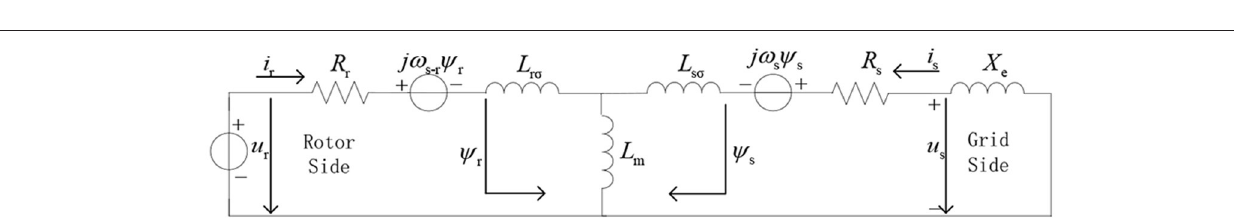
FIGURE 1 | Circuit structure of a doubly fed induction generator (DFIG) wind generator.